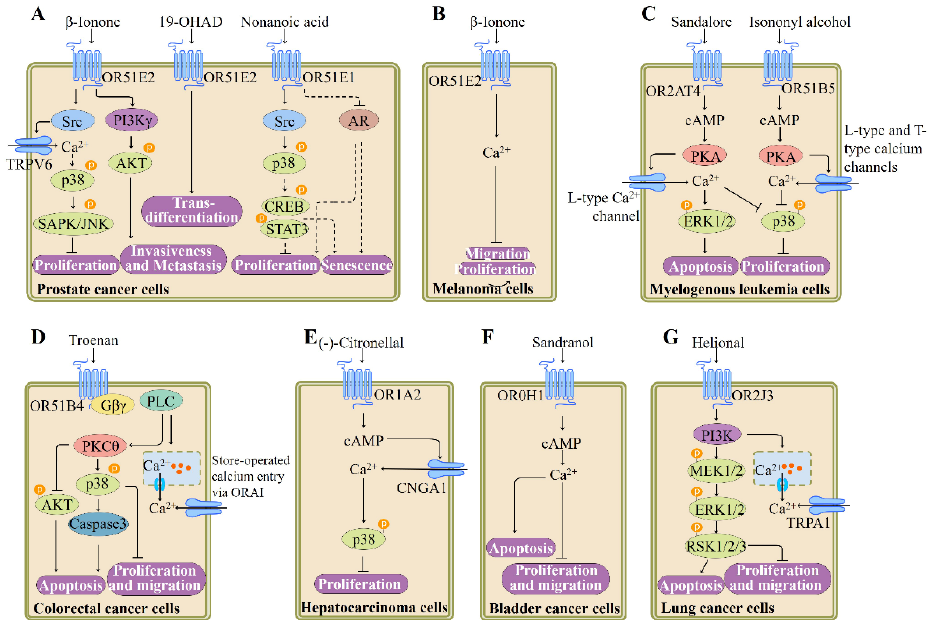
Figure 6. Summary of ectopic OR-induced signaling pathways involved in the regulation of cancer cell function. ( A ) Upon ligand ( β -ionone) binding, OR51E2 reduces the proliferation of prostate cancer cells and promotes invasiveness of prostate cancer cells. In addition, activation of OR51E2 enhances cellular transformation, leading to neuroendocrine trans-differentiation. The OR51E1 acti- vation promotes cellular senescence and inhibits the proliferation of prostate cancer cells, adapted from [110,113], published by Elsevier, 2019 and Elsevier, 2018 . ( B ) Stimulation of OR51E2 suppresses the migration and proliferation of human melanoma cells [114], published by American Society for Biochemistry and Molecular Biology, 2011. ( C ) Stimulation of OR2AT4 or OR51B5 affects the main physiological processes in human myelogenous leukemia cells, such as proliferation, apoptosis, and differentiation, adapted from [115], published by Wiley, 2017. ( D ) Activation of OR51B4 results in inhibition of proliferation and migration of colorectal cancer cells and induces apoptosis [116], published by Nature, 2016. ( E ) OR1A2 stimulation reduces proliferation of hepatocarcinoma cells, adapted from [117], published by Public Library of Science, 2017. ( F ) OR10H1 is capable of in- hibiting bladder cancer cell proliferation and migration and inducing apoptosis when stimulated by its agonist [118], published by Elsevier, 2015. ( G ) Activation of OR2J3 inhibits cell migration and proliferation and induces apoptosis in lung cancer cells [119], published by Frontiers Media S.A., 2018. AKT, protein kinase B; AR, androgen receptor; cAMP, cyclic adenosine monophosphate; CNGA1, cyclic nucleotide gated channel subunit alpha 1; CREB, cAMP-responsive element-binding protein; ERK1/2, extracellular signal-regulated kinase-1/2; MEK, mitogen-activated protein kinase kinase; ORAI, Orai calcium release-activated calcium modulator 1; PKA, protein kinase A; p38, p38 mitogen–activated protein kinases; PI3K, phosphoinositide 3-kinase; RSK, ribosomal S6 kinase; SAPK/JNK, stress-activated protein kinase/c-Jun NH2-terminal kinase; STAT3, signal transducer and activator of transcription 3; Src, sarcoma tyrosine kinase; TRPV6, transient receptor potential vanilloid type 6; TRPA1, transient receptor potential ion channel subfamily A, member